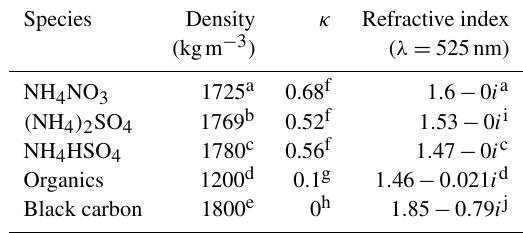
Table 1. Density, kappa values and refractive indices for aerosol species considered